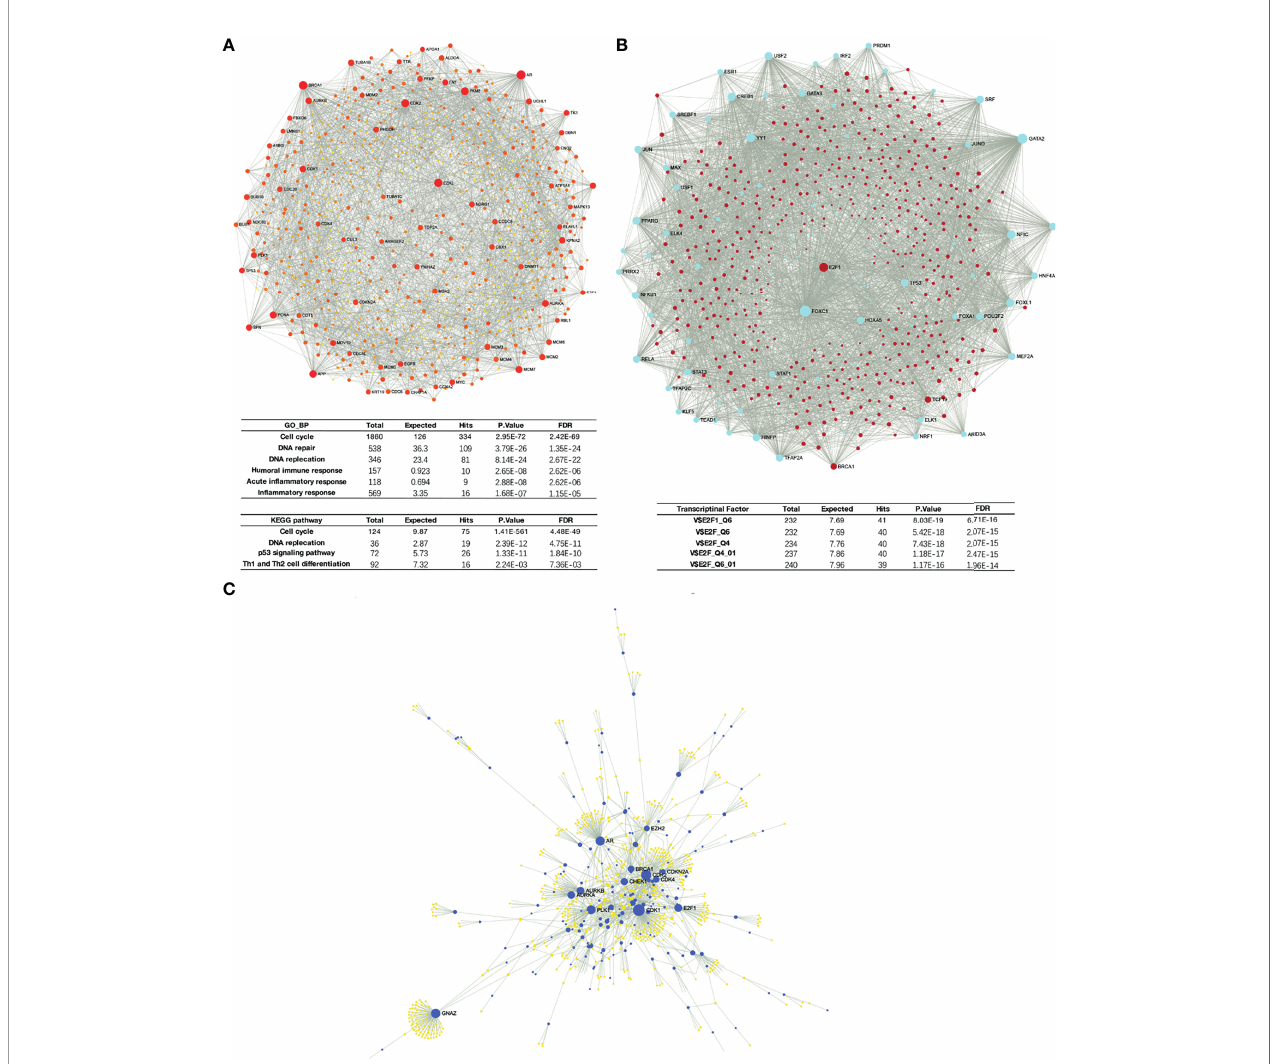
FIGURE 6 | Network analysis of DEGs. (A) Protein – protein interaction (PPI) network of DEGs. (B) TF-gene network of DEGs. (C) Signaling network of DEGs.